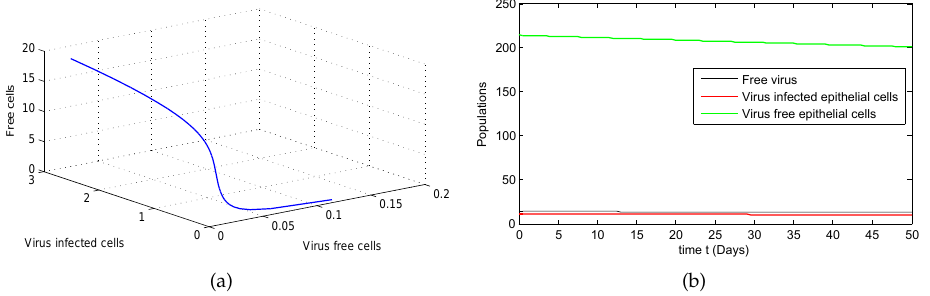
Figure 3. Dynamics of the numbers of virus-infected epithelial cells, SARS-CoV-2 virus and virus-free epithelial cells when R 0 > 1 with ( a ) three-dimensional plot and ( b ) two-dimensional